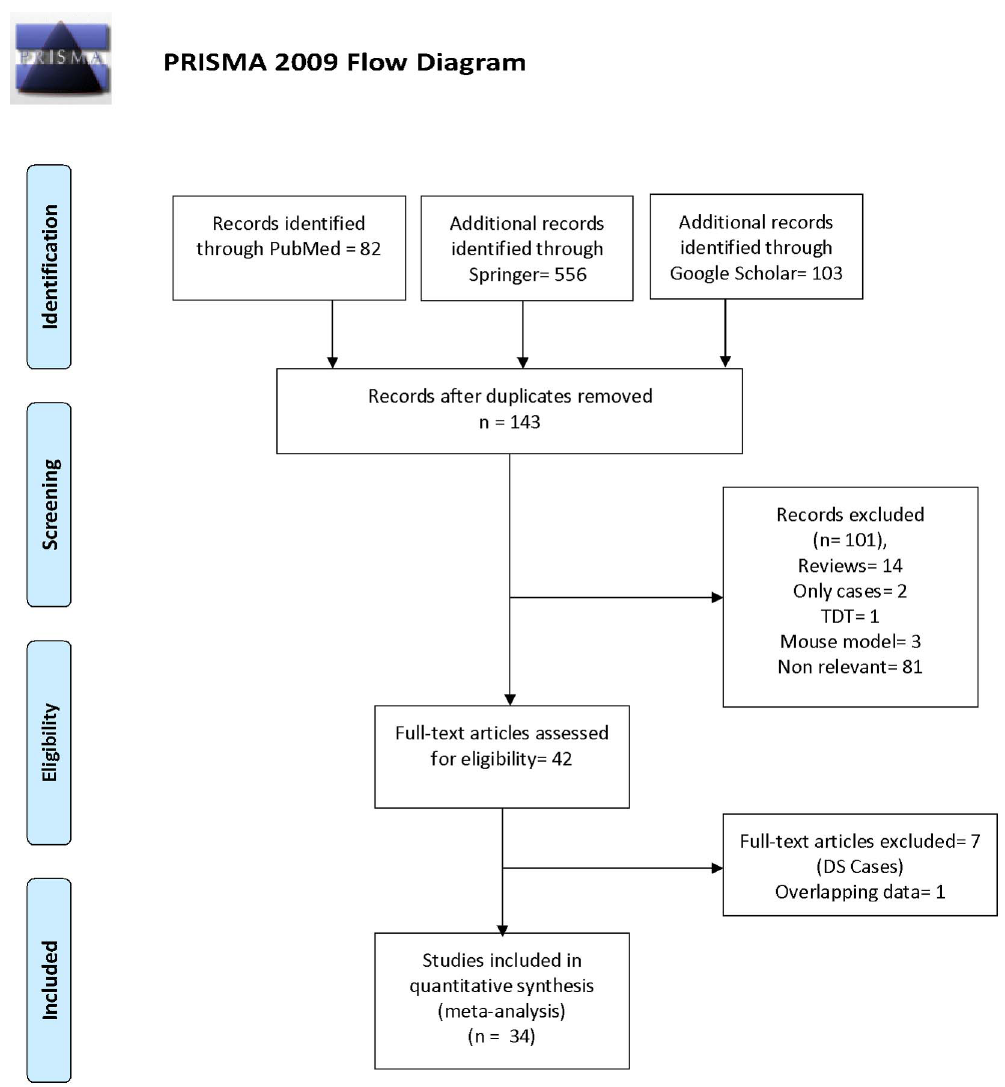
Figure 1. Flow Diagram of Study Searching and Selection Process.